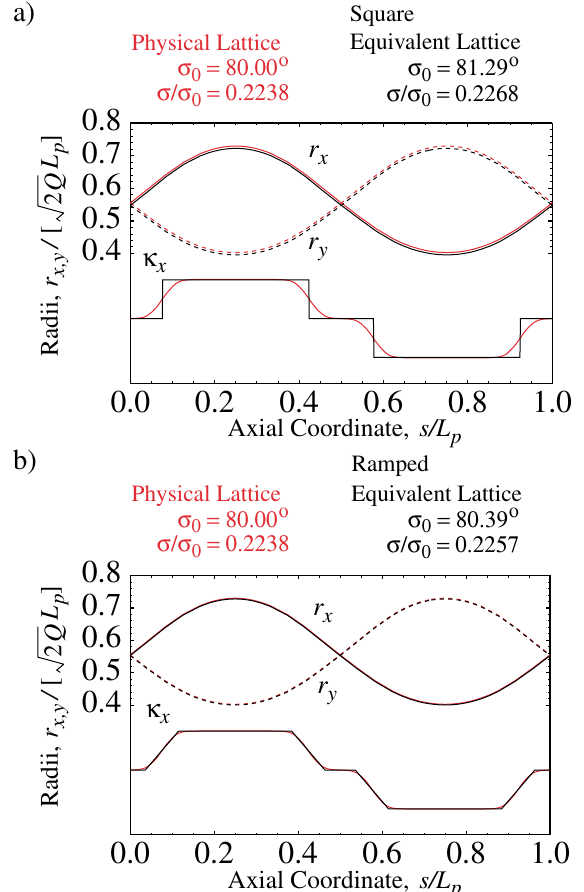
FIG. 23. (Color) Comparison of matched beam envelopes cal- culated from a full fringe field model (red) and an equivalent fringe model (black) for (a) the square-edge and (b) the ramped-edge models shown in Fig. 22. The presentation format of the matched solutions is the same as in Fig. 15. Both the physical and equivalent fringe model lattices have the same quadrupole excitation, beam parameters are Q (cid:1) 8 : (cid:22) 10 (cid:2) 4 (cid:1) " (cid:1) 60 mm mrad , and the undepressed and de- and " x y and (cid:24) are listed pressed single-particle phase advances (cid:24) 0 above the